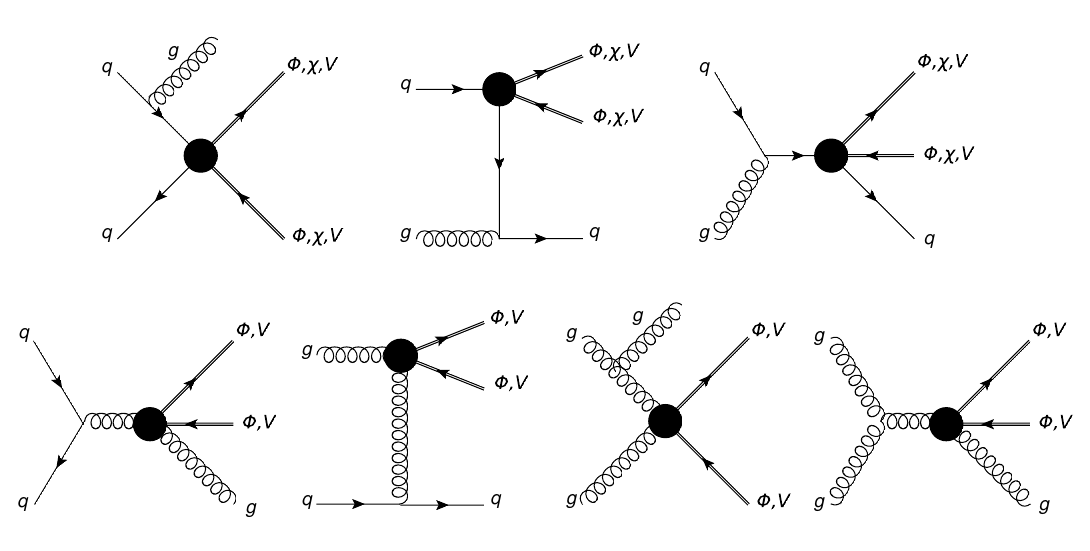
Figure 1 . Feynman diagrams for monojet processes for the operators listed in table 1. All 7 diagrams are possible for scalar and vector DM, whilst only the top 3 diagrams occur for fermion DM as we do not consider the GG(cid:31)(cid:31) (dimension-7)